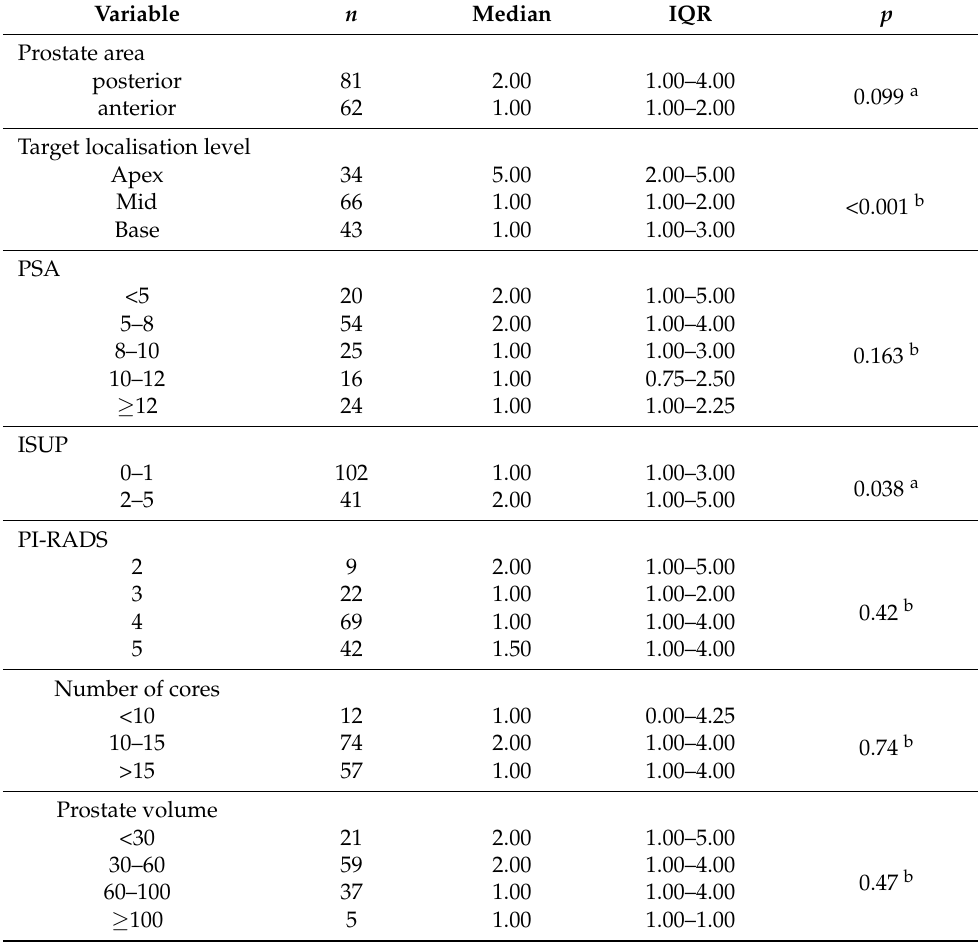
Table 2. The assessment of the relationship between perceived pain and clinical data.